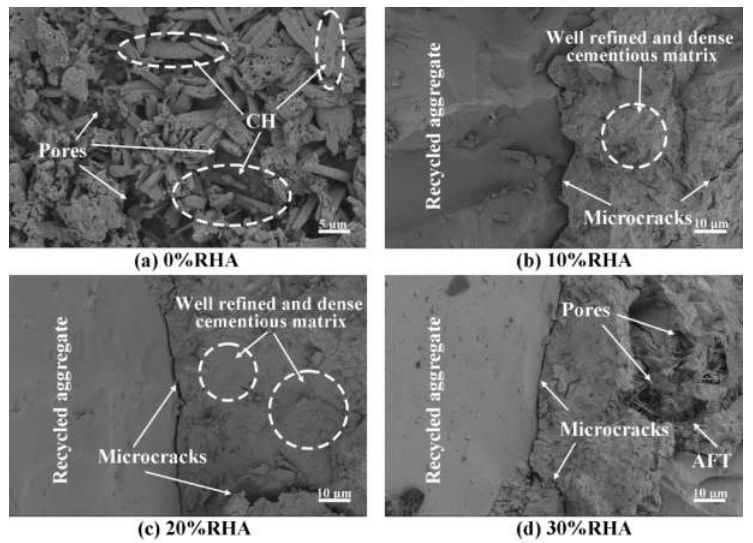
Figure 8. Microscopic morphology of the paste samples with different RHA replacement ratios be- fore the freeze–thaw cycles. the freeze–thaw